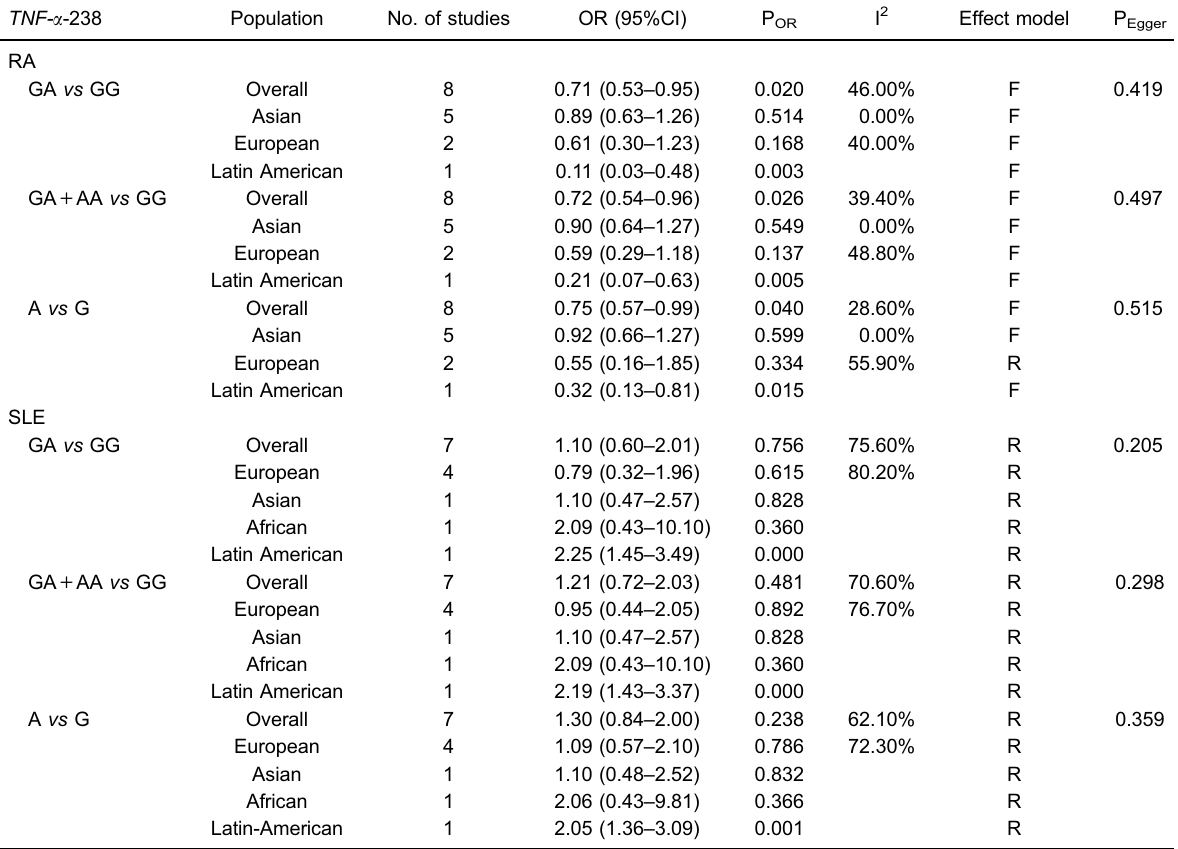
Table 1. Summary of pooled odds ratio (OR) and 95% con fi dence interval (CI) for the association of TNF- a -238 single-nucleotide polymorphisms with rheumatoid arthritis (RA) and systemic lupus erythematosus